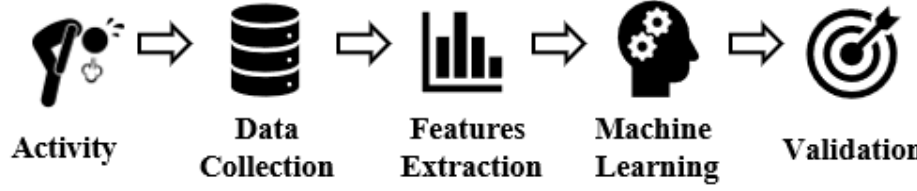
Figure 5. Overview of the wearable approach based human activity recognition